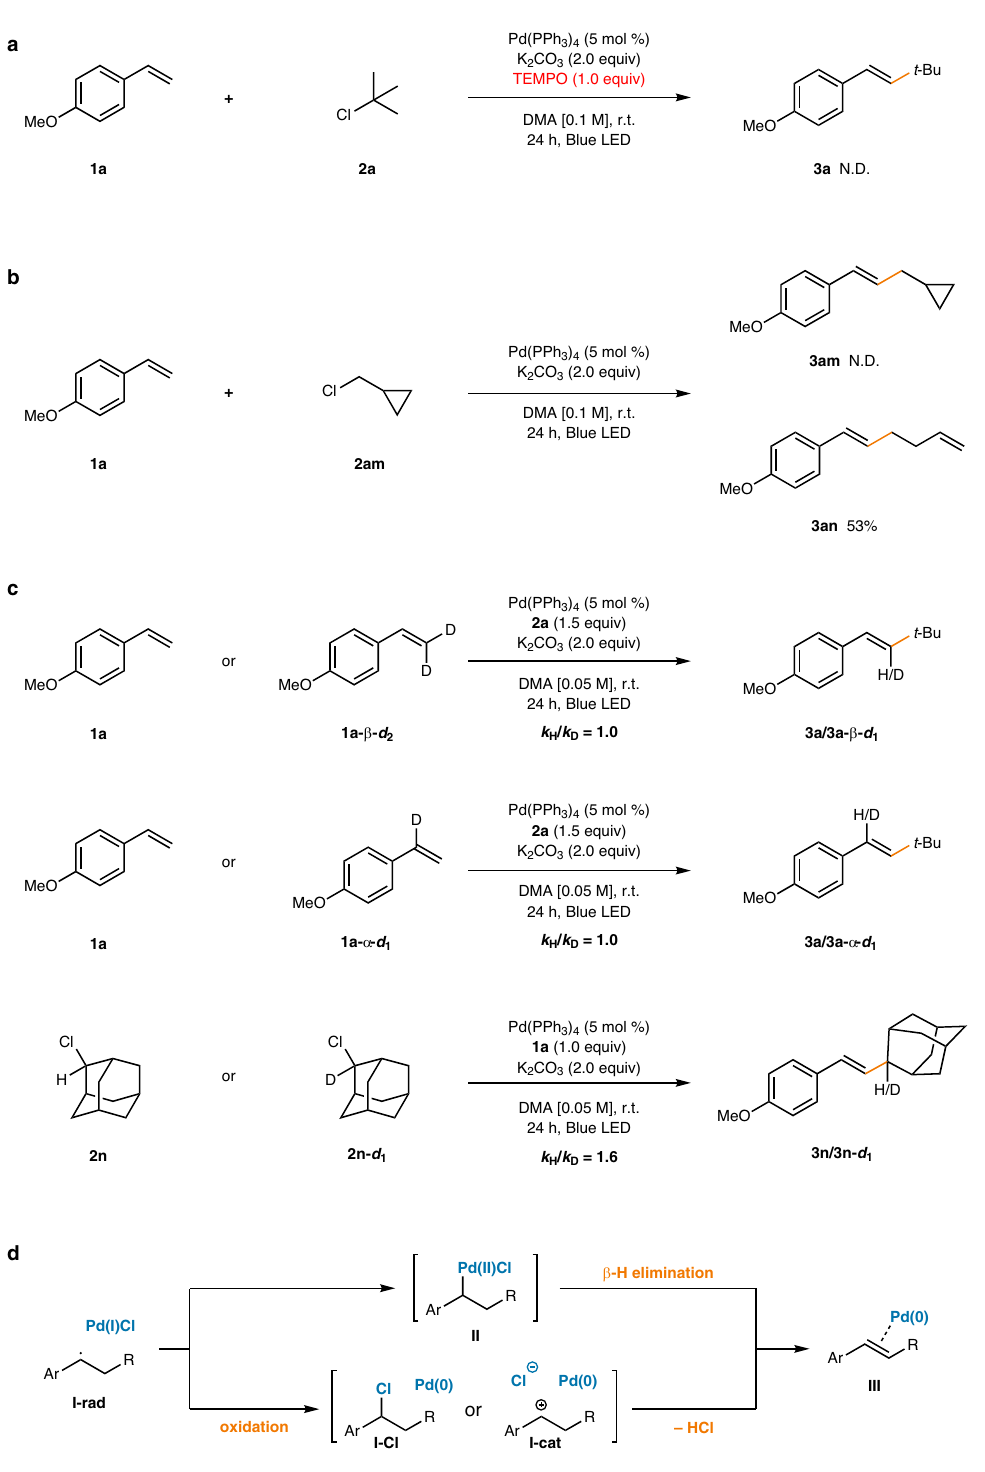
Fig. 2 Mechanistic studies. a TEMPO as radical scavenger. b Radical clock experiment. c Kinetic isotope effect measurements. d Possible product forming catalyst turnover